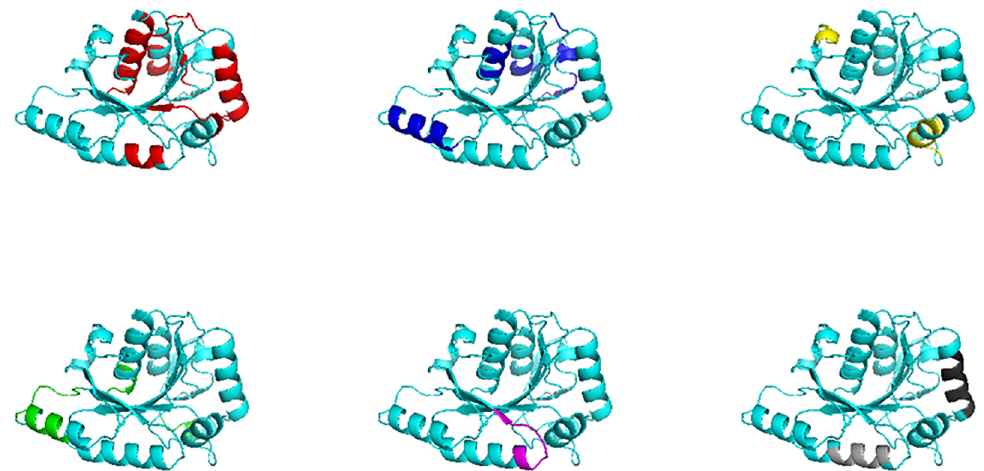
Fig 6. Structure of dethiobiotin synthase (PDB ID 1byi) represented in cartoon representation showing mapped BPs. Red indicates ACE inhibitor BP activity (14), blue antibacterial (4), yellow inmunomodulating (3), green antioxidative (3), magenta neuropeptide (1), light grey chemotactic (1) and dark grey stimulating activities (1) (as derived from BIOPEP database). It is possible to see that different activities have similar location. BPs found in different proteins of the same superfamily have been mapped on a representative structure (1byi) accordingly to CATH (see Materials and